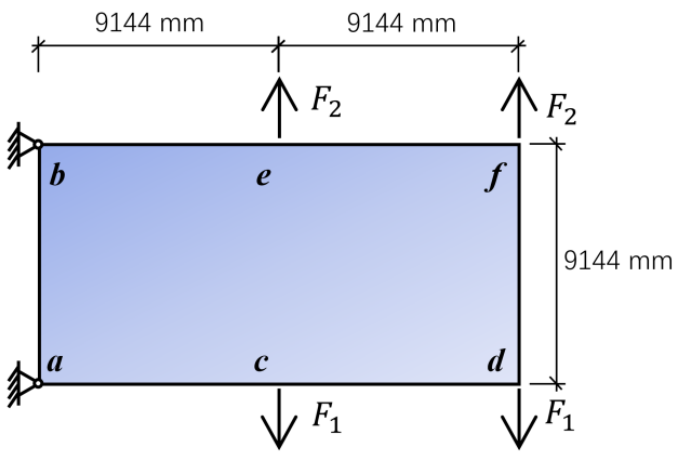
Figure 8. Design domain for experiment 2. In each load case, F 1 and F 2 represent the different load sizes of nodal load and the specific value can be found in Table 4. Table 4. Essential node information in experiment 2.